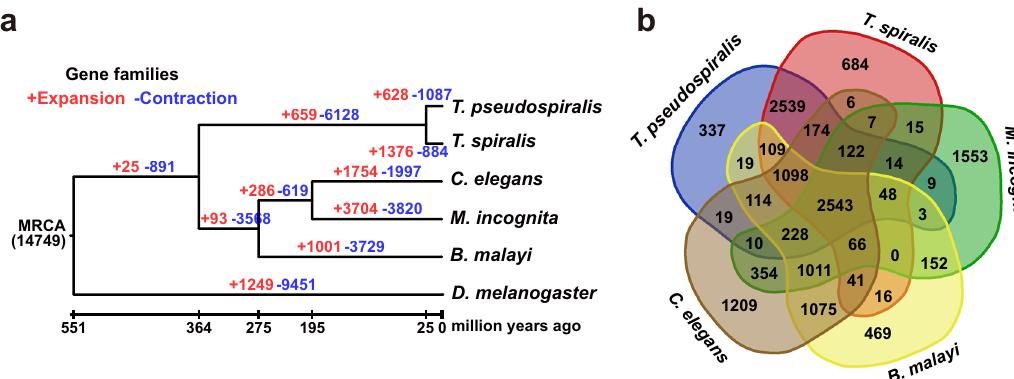
Fig. 2 Comparative genomics between T. pseudospiralis and T. spiralis . a The dynamics of gene family sizes in the genomes of parasitic nematode T. pseudospiralis , T. spiralis , C. elegans , M. incognita , B. malayi , with D. melanogaster serving as the outgroup. Numbers above the branches represent gene family expansion and contraction events, respectively. The plus sign represents expansion events and the minus sign indicates contraction events. b Number of shared gene families between T. pseudospiralis and four other nematodes (that is, T. spiralis , C. elegans , M. incognita , and B. malayi